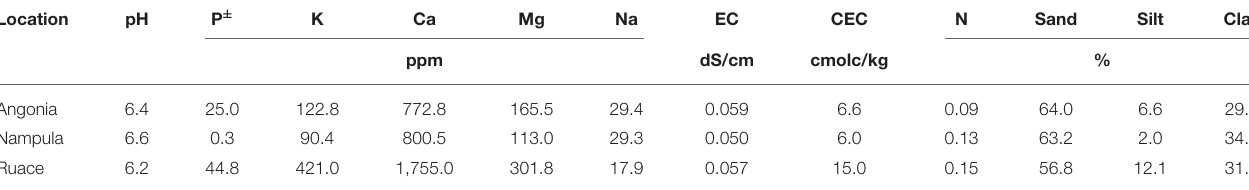
TABLE 1 | Soil characteristics of the three sites used for the inoculation trial. Location pH P ± K Ca Mg Na EC CEC N Sand Silt Clay ppm dS/cm cmolc/kg %